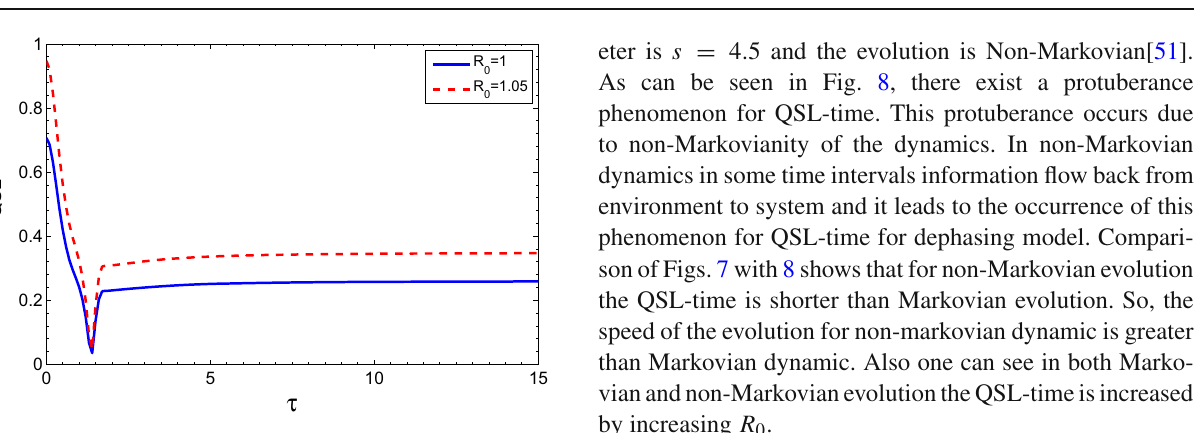
Fig. 8 The QSL-time for the Ohmic-like dephasing model as a func- tion of the initial time parameter τ for super-Ohmic environment. The Ohmicity parameter is s = 4 . 5 and Ω = 10